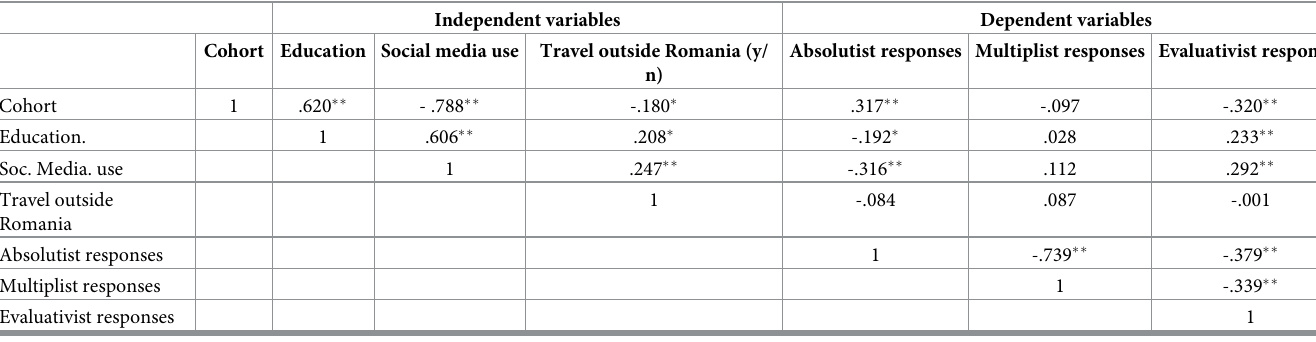
Table 1. Intercorrelations of independent and dependent